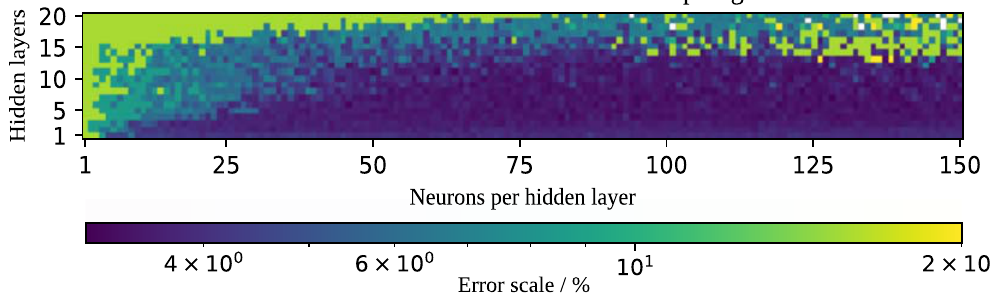
Figure 3: Heatmap of MLP topology ( arch heatmap flat.py )